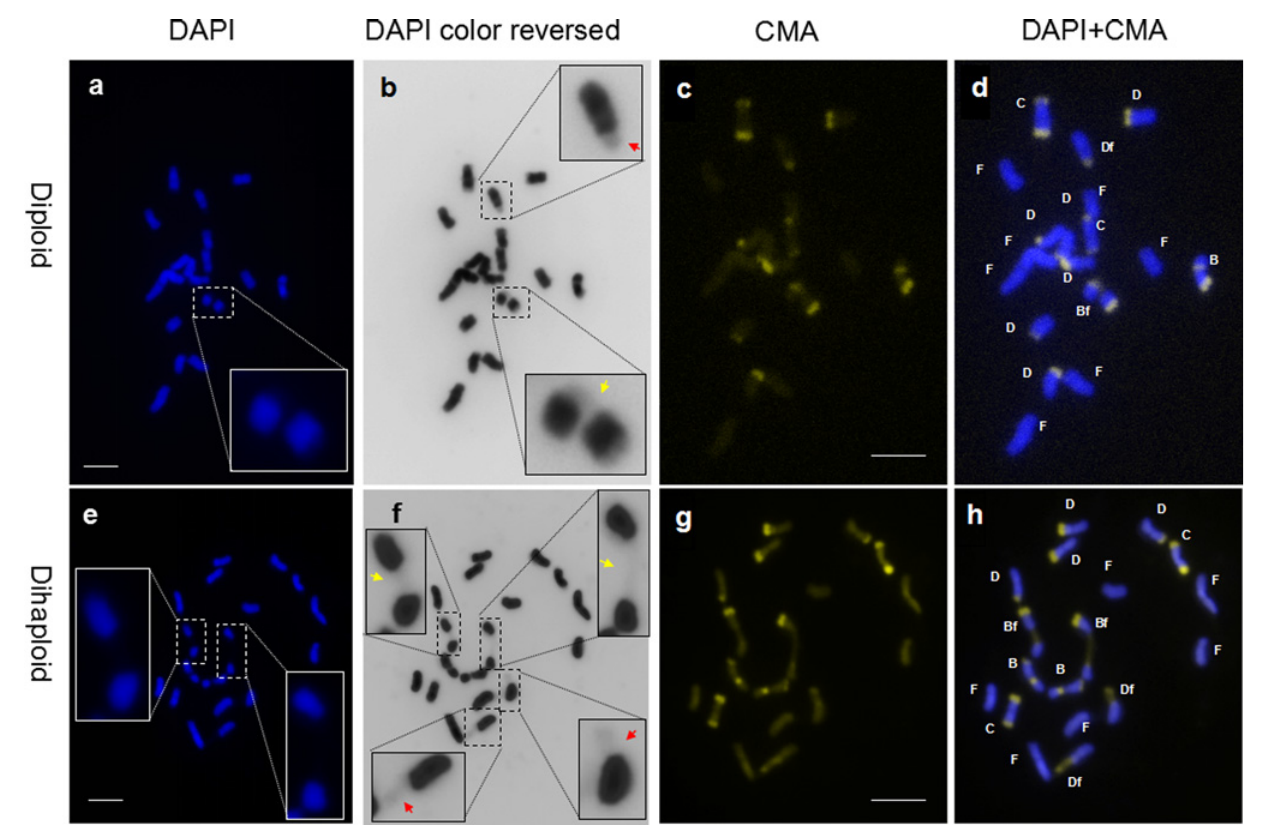
Fig 2. DAPI/CMA doubled fluorescence banding of C . sinensis (diploid) and its doubled haploid callus line (dihaploid). a and e, DAPI staining chromosomes; b and f, reverse image of image a and e for the visualization of fragile sites in metaphase chromosomes (yellow arrows indicate the proximal fragile sites and the red ones indicate subterminal fragile sites); c and g, CMA staining chromosomes; d and h, merged images of DAPI/CMA staining chromosomes (B, Bf, C, D, Df and F indicate the type of each chromosome).The chromosomes with fragile site are enlarged in more detail. Bar scales = 5 μ